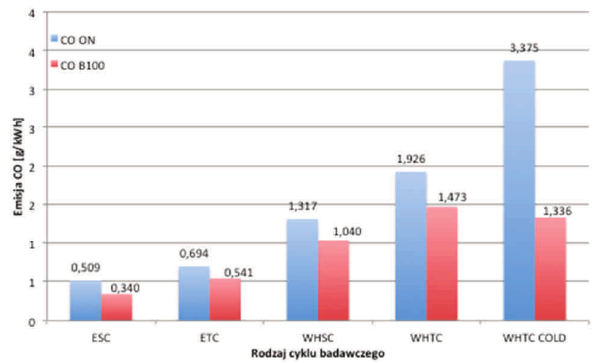
Fig. 8. Comparison of CO emission in an engine fuelled with diesel and B100, depending on the type of test